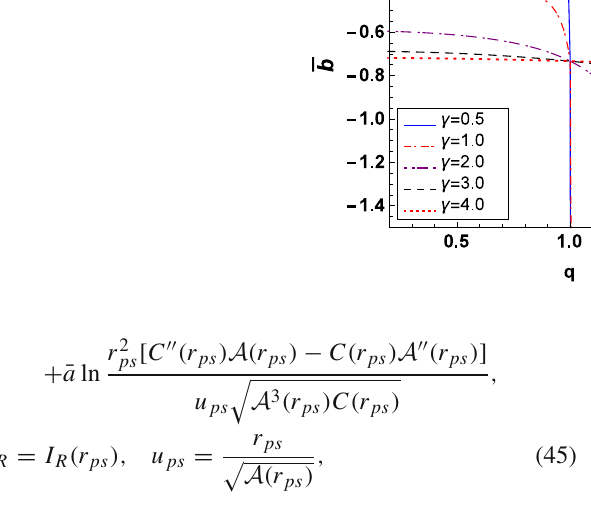
Fig. 6 Change of the strong deflection limit coefficients ¯ a and ¯ b with the parameters γ and q in the spacetime with torsion